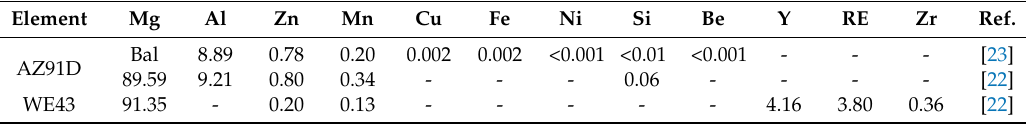
Table 1. Chemical composition of AZ91D and WE43 alloys (wt